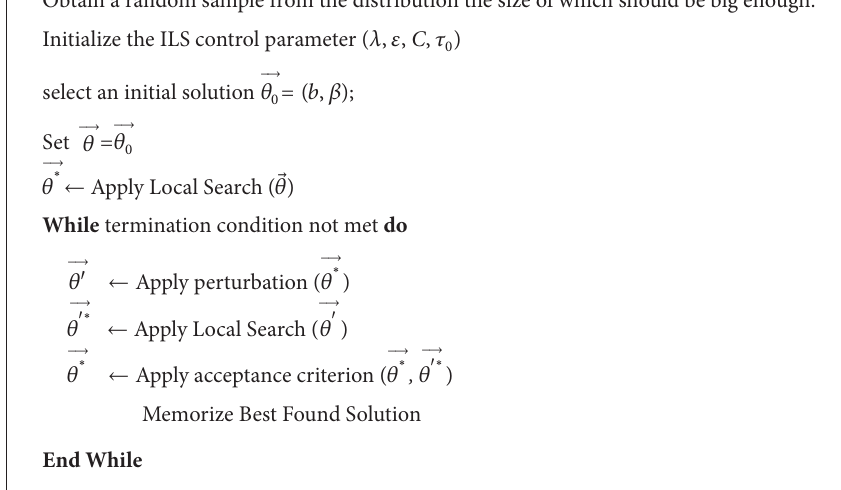
Algorithm 2: Proposed hybrid iterated local